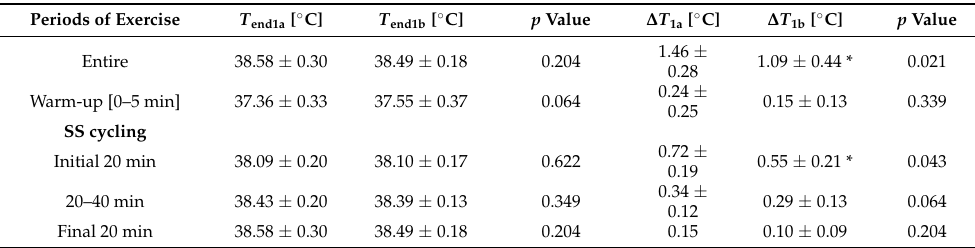
Table 2. Mean core body temperatures indicated by the CORE sensor during the final 30 sec of Trial 1a ( T end1a ) and Trial 1b ( T end1b ), as well as of each individual phase. In addition, the fourth and fifth columns document the corresponding total increase in